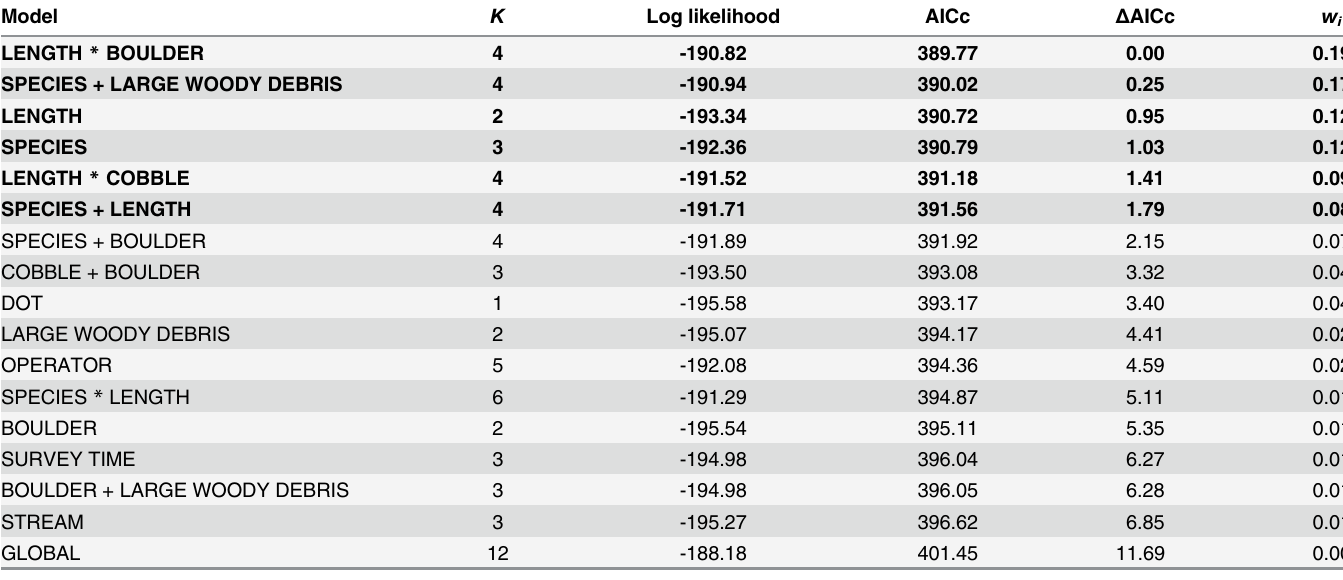
Table 2. Model ranking statistics for models describing factors influencing portable antenna detection